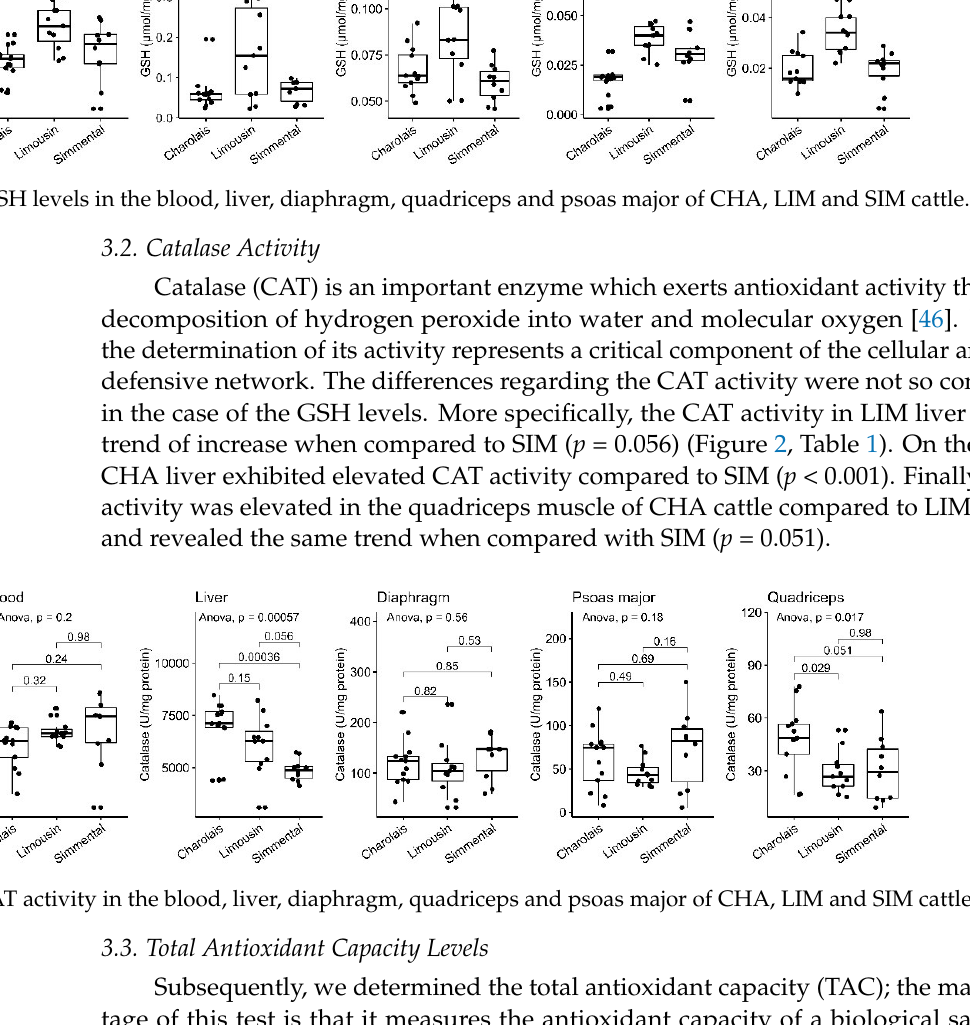
Figure 2. CAT activity in the blood, liver, diaphragm, quadriceps and psoas major of CHA, LIM and SIM cattle.